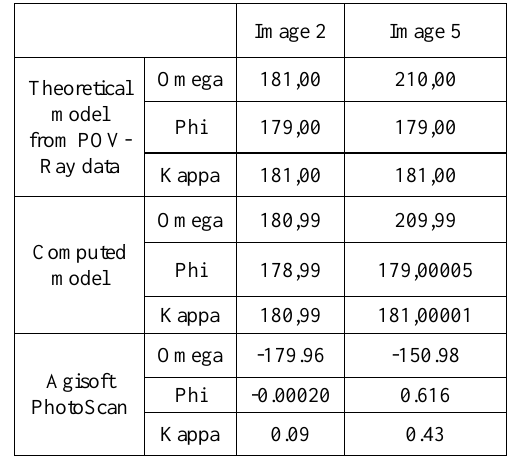
Table 1. External orientation, comparison between data from POV-Ray, results from Arpenteur framework and Agisoft PhotoScan.